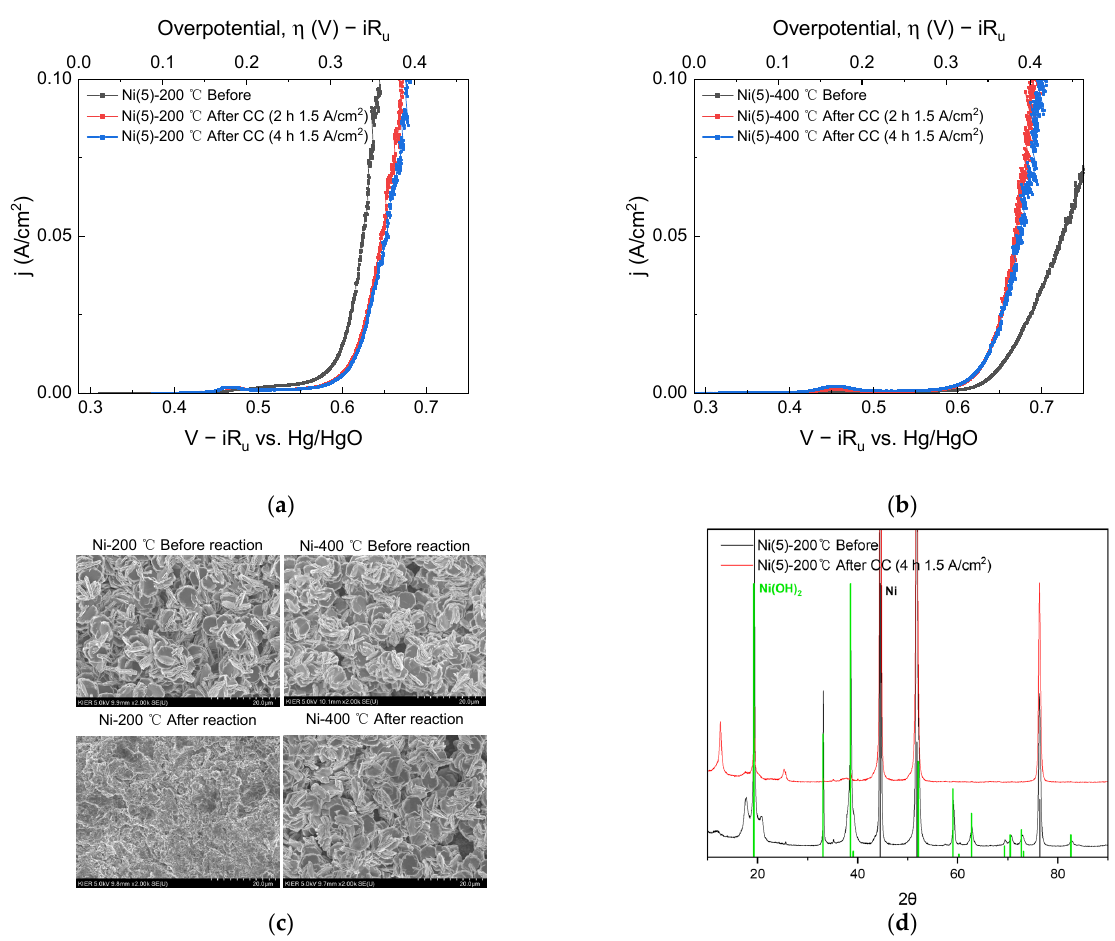
Figure 1. LSVs taken before (black) and after (red) 30 h CC (1.5 A/cm 2 ) operation: ( a) Ni(5)-200 °C and ( b ) Ni(5)-400 °C.